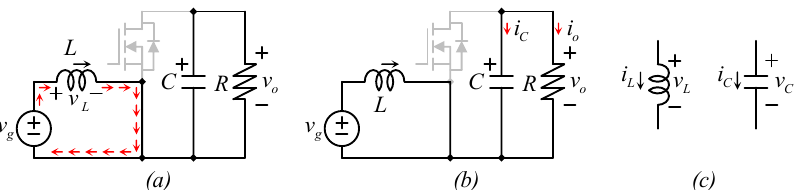
Figure 2. Equivalent circuit state when s 1 = 1 showing: ( a ) the voltage loop of the inductor, ( b ) the current node in the capacitor, ( c ) passive sign convention.